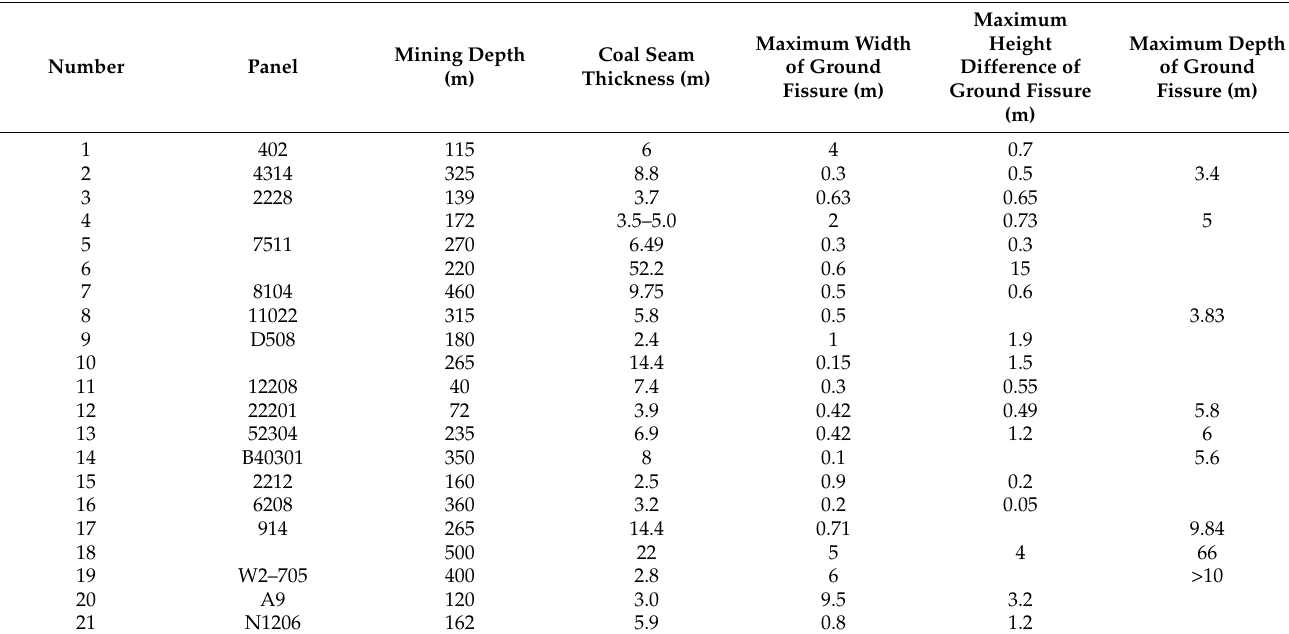
(b) Topographic Parameters of Mine Ground